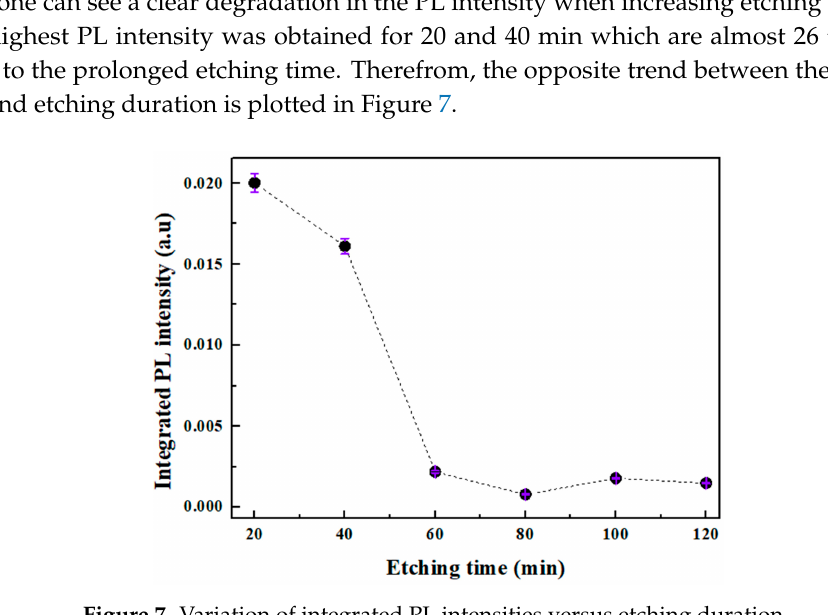
Figure 6. PL spectra of SiNWs synthesized at different etching times.